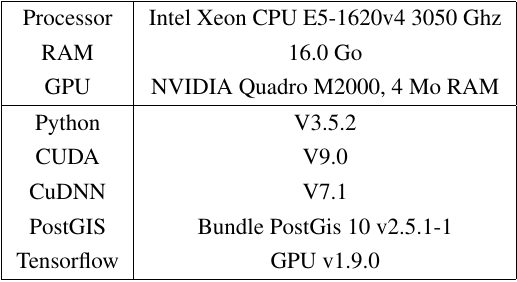
Table 1. Computeur